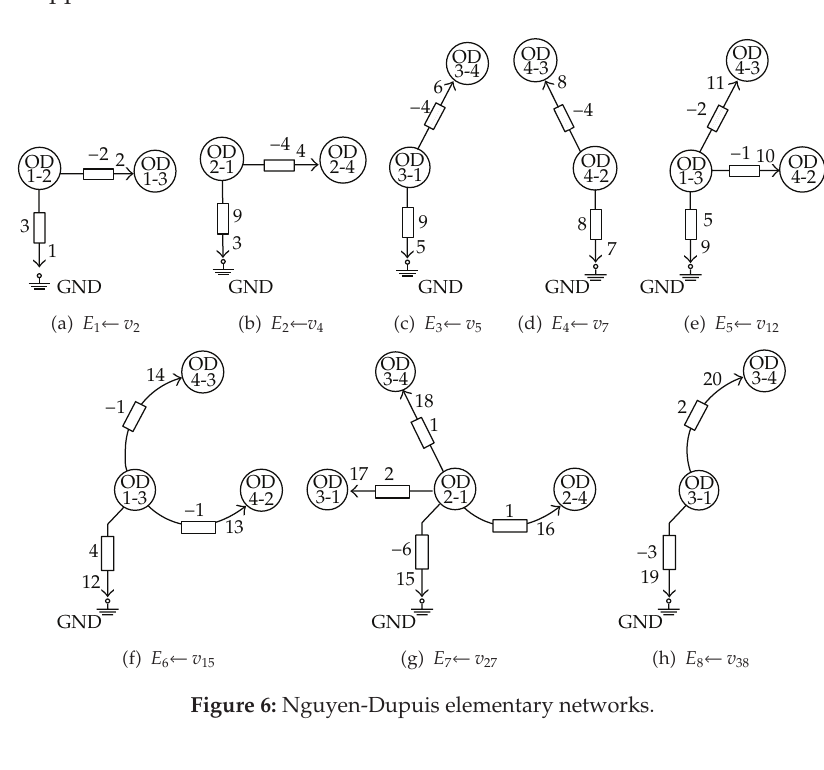
Figure 6: Nguyen-Dupuis elementary networks.